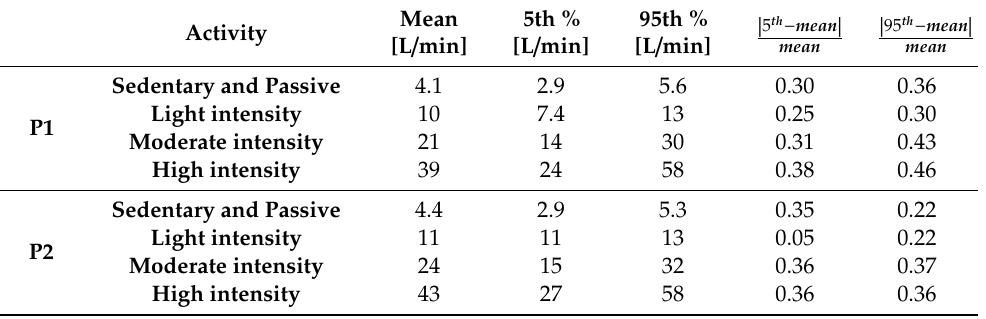
Table 1. Mean, 5th, and 95th percentile minute ventilation values for P1 and P2 with calculated di ff erences between the percentiles and the mean, provided in the Environmental Protection Agency (EPA) Exposure Handbook